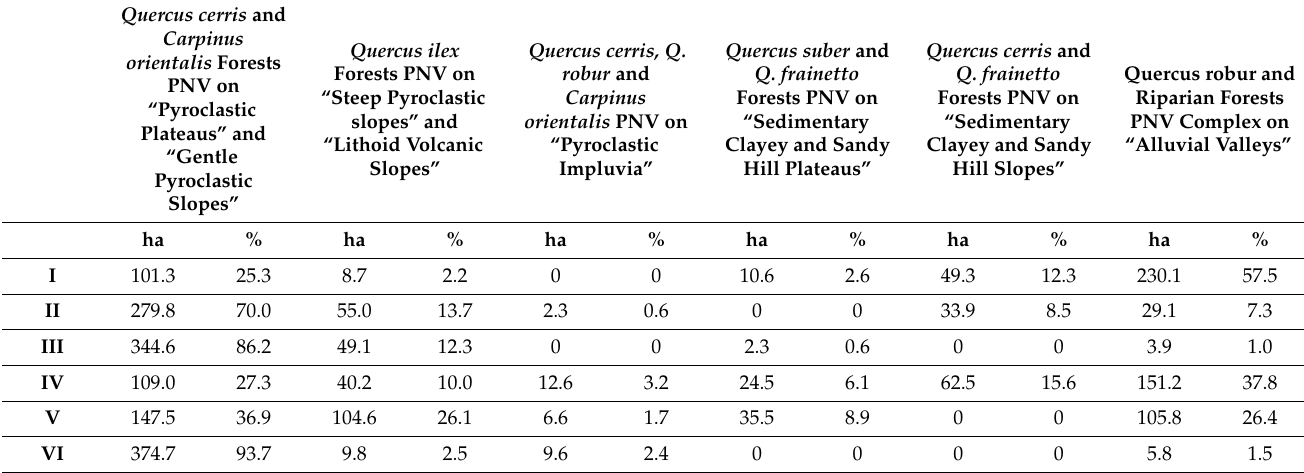
Table 3. Total (ha) and proportional (%) extent of Environmental Units (EUN)/Potential Natural Vegetation (PNV) types across the grid